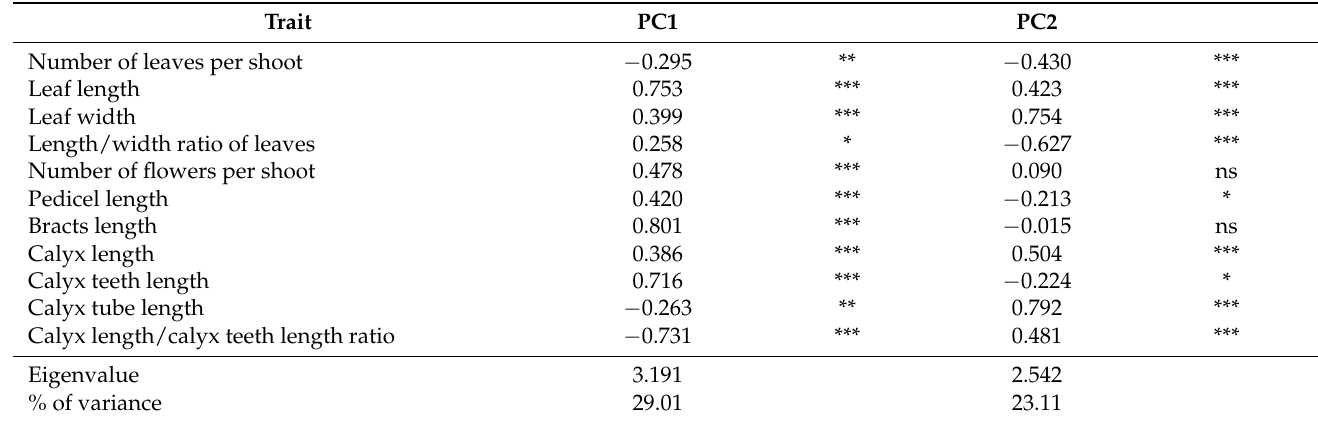
Figure 7. PCA of the investigated Micromeria croatica populations from Croatia (Cr1–Cr5), Bosnia and Herzegovina (BH1–BH4), and Montenegro (Mn) based on 11 morphological traits. nL, number of leaves per shoot; LL, leaf length; LW, leaf width; LL/LW, length/width ratio of leaves; nF, number of flowers per shoot; PL, pedicel length; BL, bracts length; CL, calyx length; TL, calyx teeth length; TuL, calyx tube length; CL/TL, calyx length/calyx teeth length ratio. The length of the vector is proportional to the eigenvector of the variable, scaled by the square root of the eigenvalue. Table 7. Pearson’s correlation coefficients between analyzed morphological traits and scores of the first two principal components